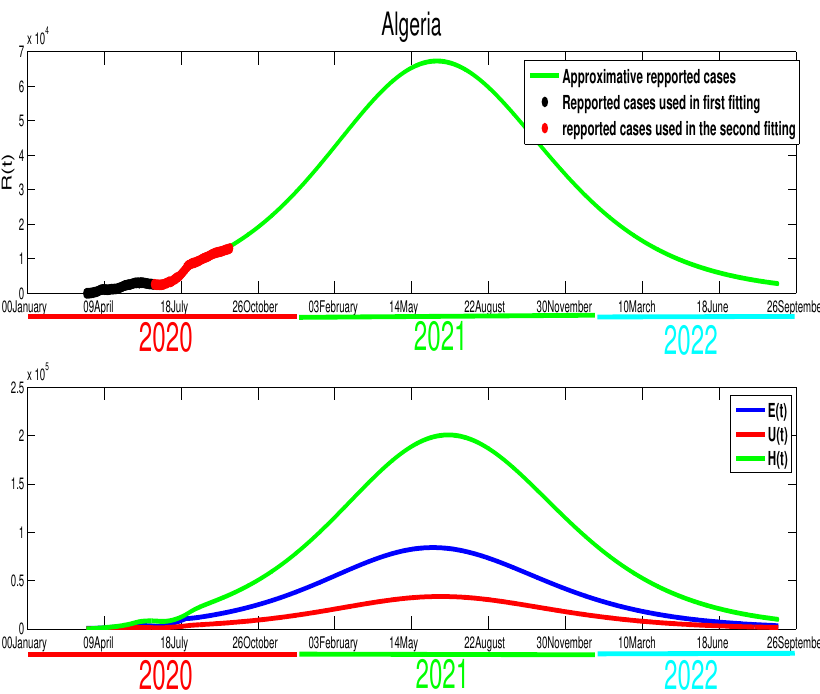
Figure 12. The projection of the number of COVID-19 cases in Algeria.